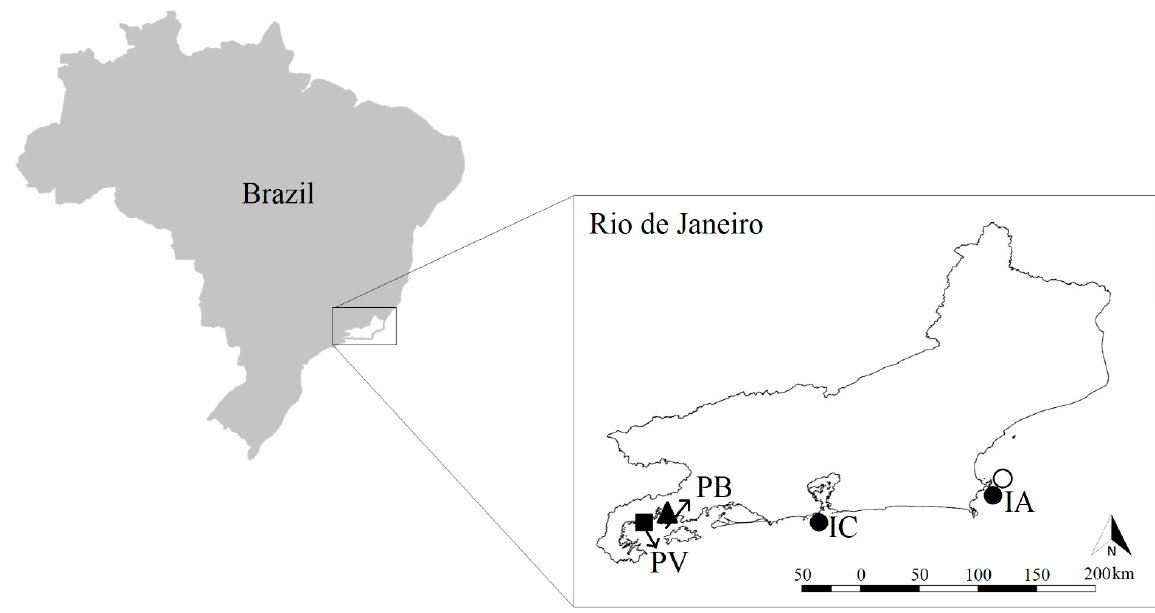
Figure 1. Map of the four study sites along the coast of the state of Rio de Janeiro, Brazil and their respective alien species. cs = green alga Caulerpa scalpelliformis ▲ , s = soft coral Sansibia sp. ■ , tt = azooxantellated coral Tubastraea tagusensis ● , tc = azooxantellated coral Tubastraea coccinea ○ , PV = Praia Vermelha, PB = Praia da Baleia, IC = Ilha Comprida and IA = Ilha de Âncora. Diversity 2021 , 13 , x FOR PEER REVIEW